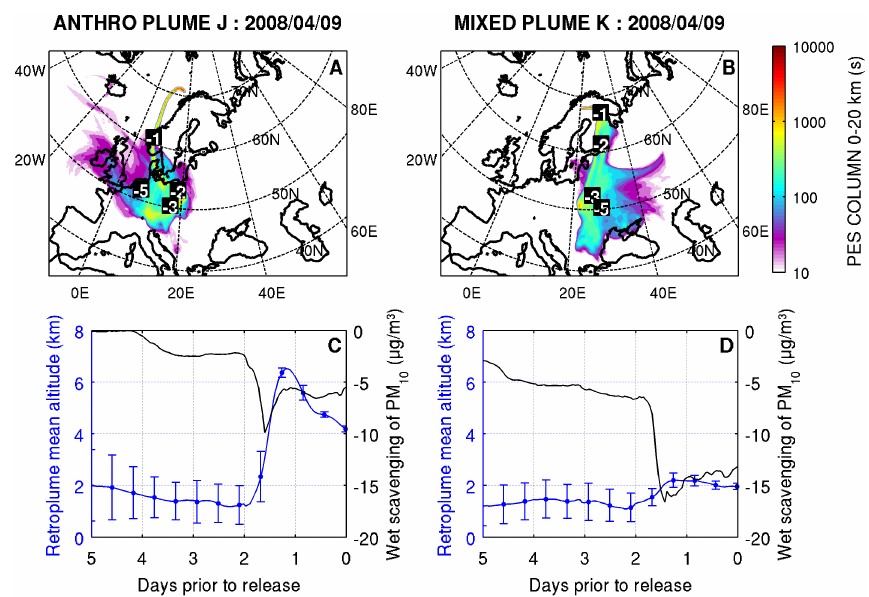
Figure 9. Backward mode FLEXPART-WRF column-integrated PES (a and b) , showing typical transport pathways for an anthropogenic plume (left, plume J, originating on 9 April 2008 at 11:19UTC on the POLARCAT flight track) and a mixed anthropogenic/biomass burning plume (right, plume K, originating on 9 April 2008 at 12:19UTC on the flight track). Numbers in white indicate the plume age, in days. Panels (c) and (d) show each plume’s mean altitude with rms error bars showing vertical dispersion (blue) and the difference between the CTL PM 10 and the NOWETSCAV PM 10 along transport, indicating wet scavenging events